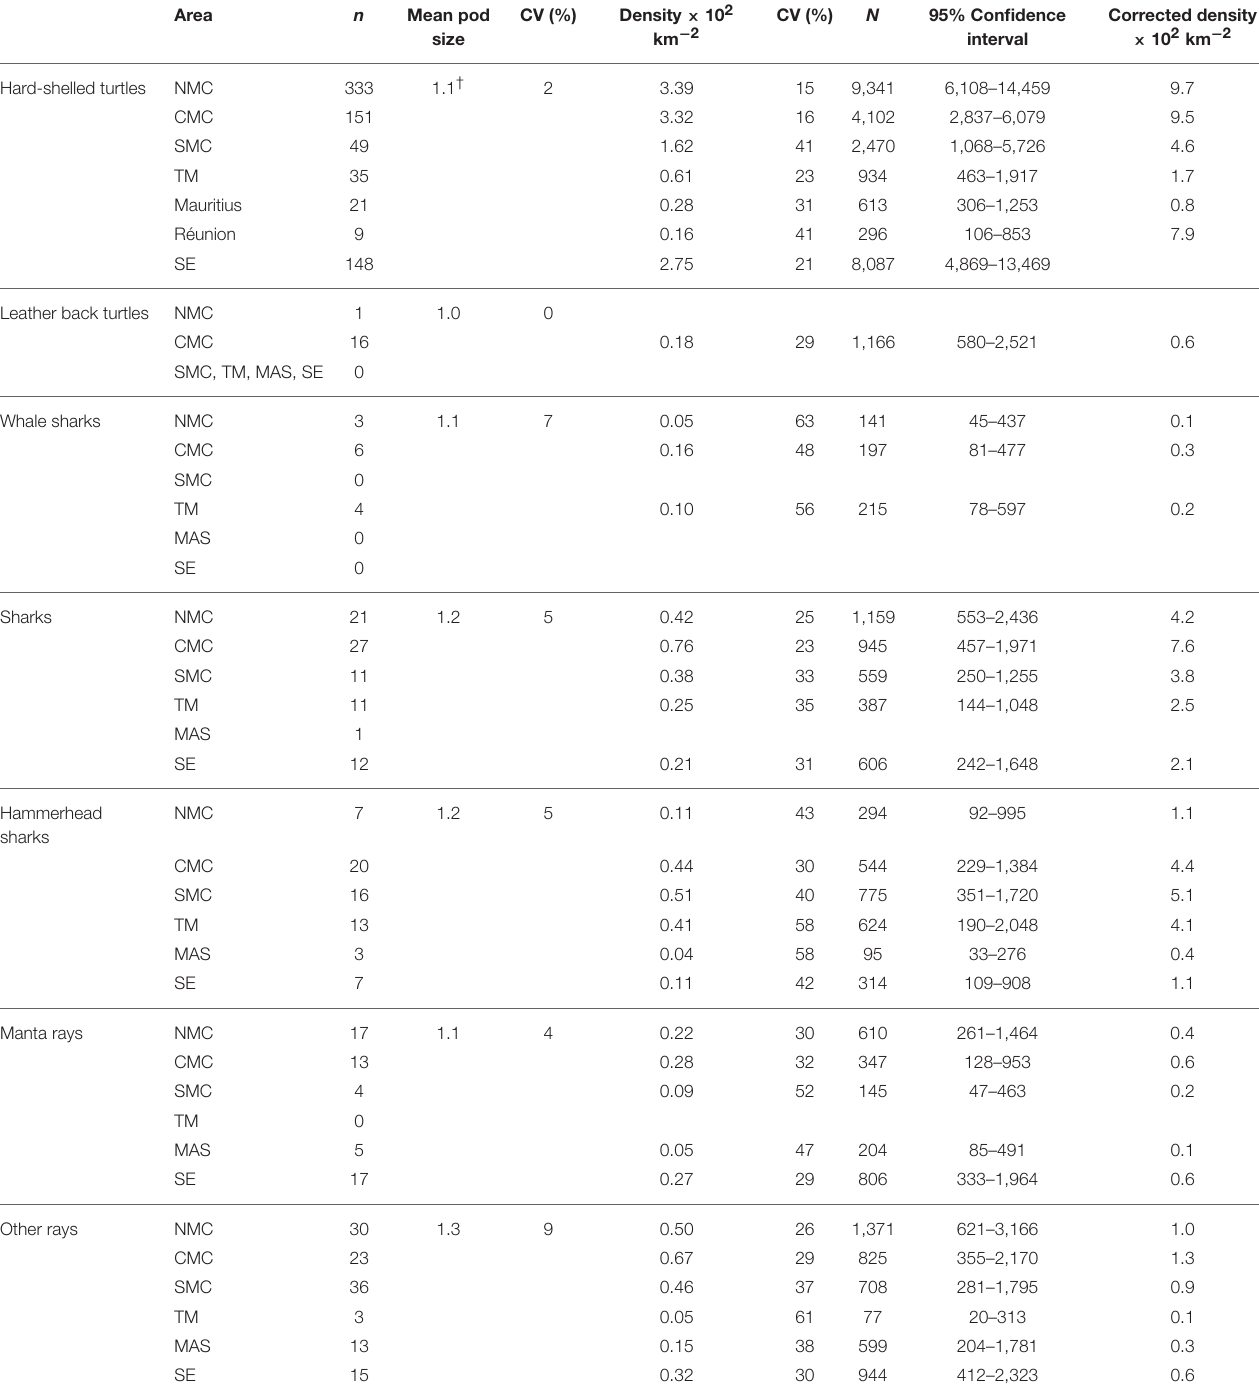
TABLE 5 | Results obtained for elasmobranchs and turtles: sightings number ( n ), mean pod size, uncorrected densities with corresponding relative abundance ( N ) estimated per taxonomic group and survey blocks and corrected density considering different availability bias factor per group of species. Area n Mean pod size Hard-shelled turtles